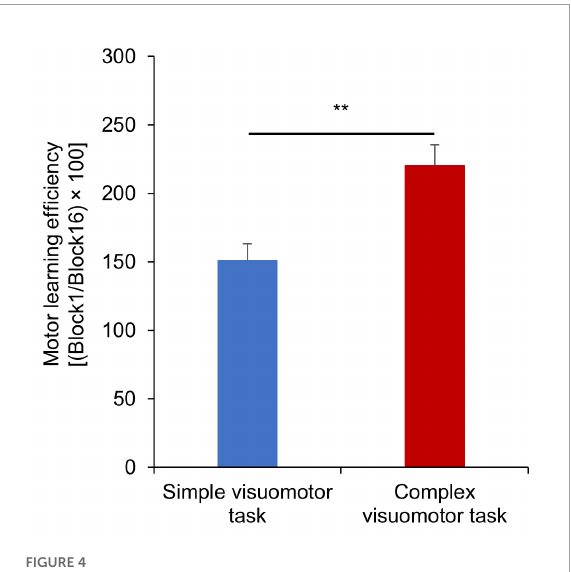
FIGURE3 Change in the task error under each condition. The blue and red lines indicate the average task error of the simple and complex visuomotor tasks, respectively. ∗ p < 0.05 (vs. Pre); ∗∗ p < 0.01 (vs. Pre).